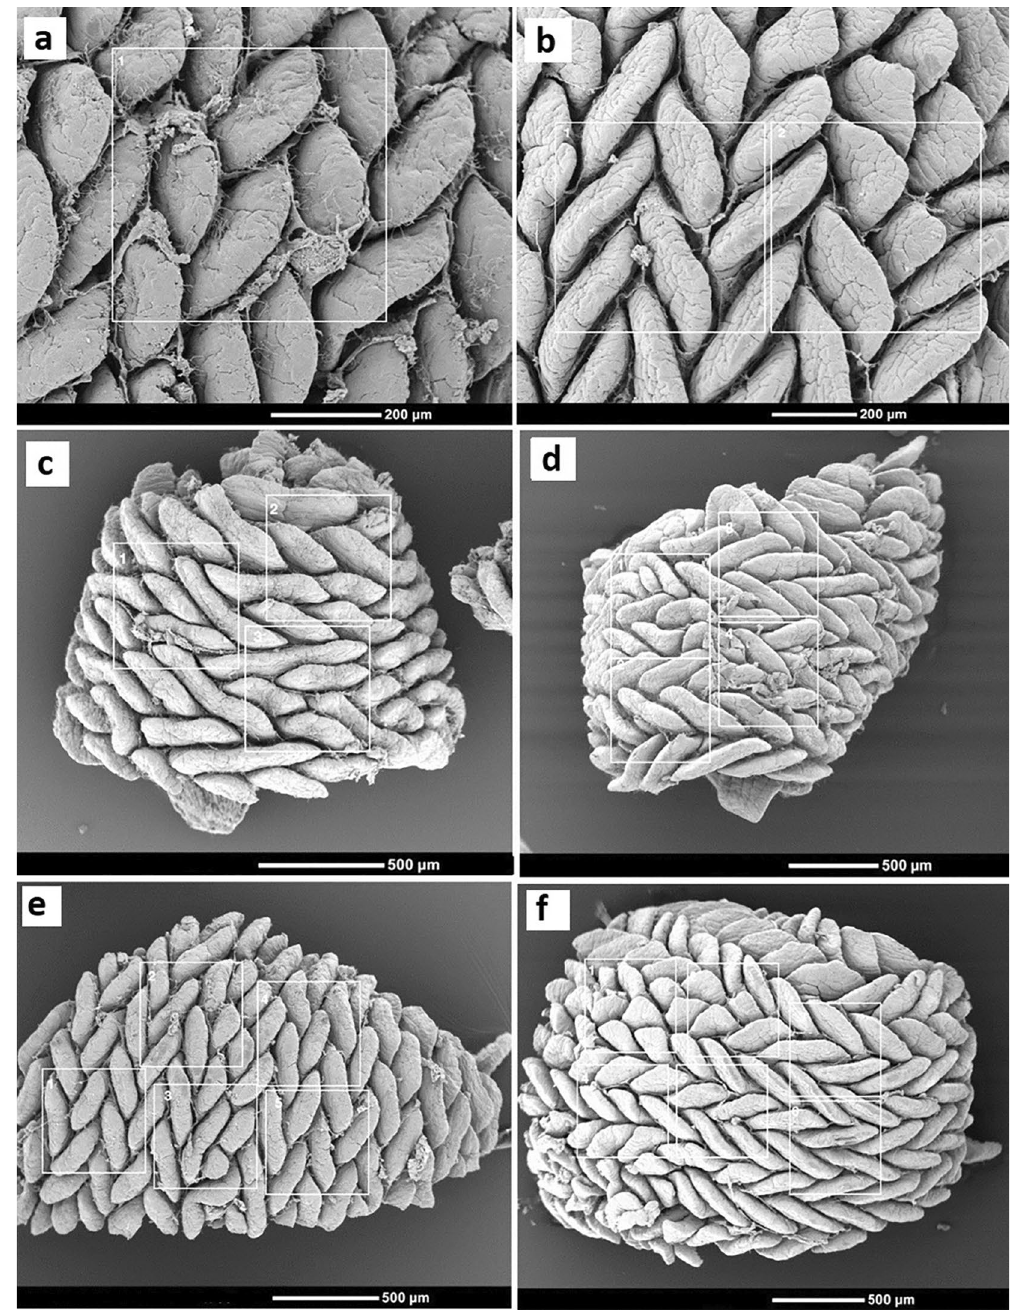
Figure 7. Scanning electron micrographs of villi from the ileum of 21 d old chicks. Shown are image examples that were employed to measure villus density. Images from different treatments fitting one ( a ) or more ( b – d ) squares. Villi within squares were counted and density was expressed as the number of villi/2500 µM 2